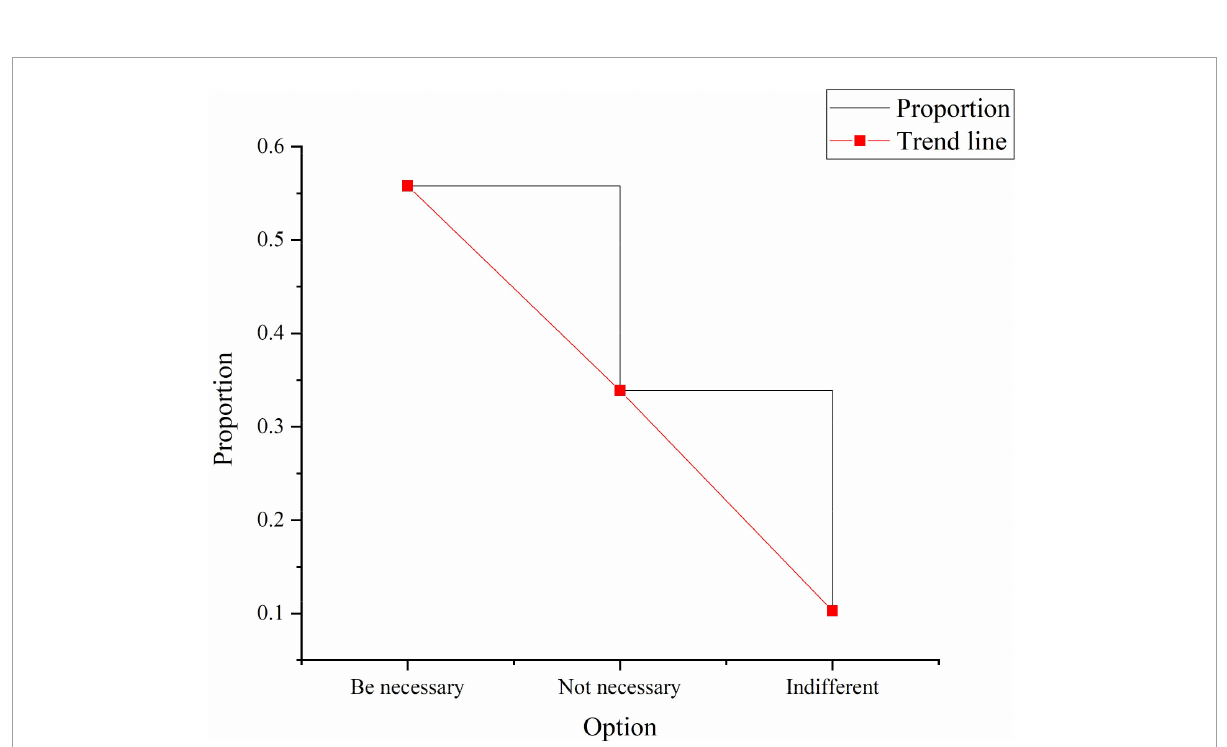
FIGURE9 Investigation of the integration of entrepreneurial spirit into the construction of sports